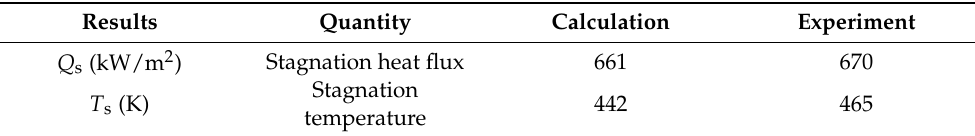
Figure 4. Dimensionless heat flux and dimensionless temperature distributions of the outer wall at 2 s: ( a ) heat flux; ( b ) temperature. Table 3. Comparison of calculated and experimental results.